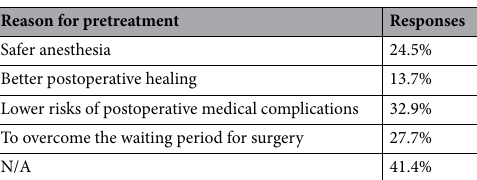
Table 2. The rationale for ACTH-secreting adenomas pretreatment (according to neurosurgeons).